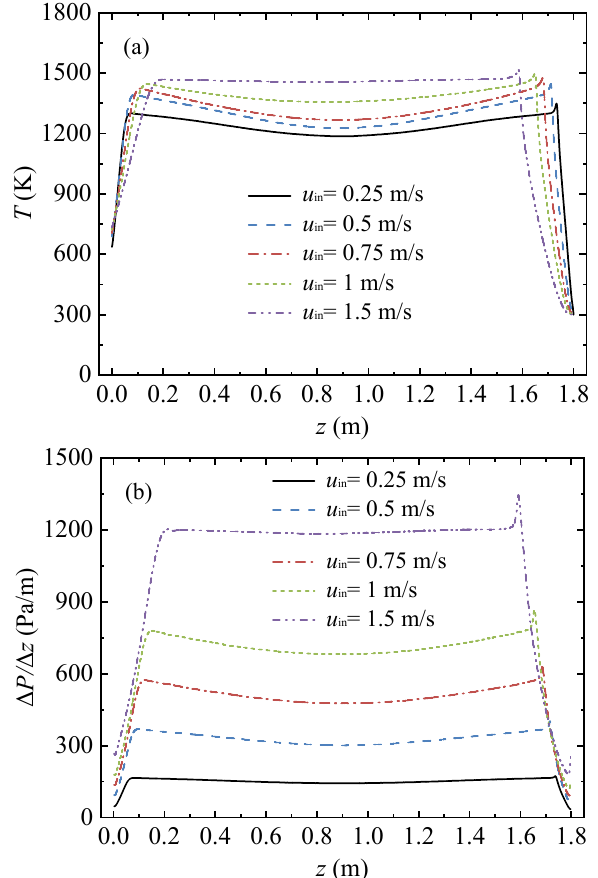
Figure 4. Gas temperature and pressure gradient profiles along the arial direction in the conduit, with various inlet velocities: ( a ) gas temperature profiles and ( b ) pressure gradient